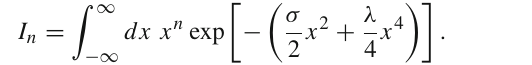
Fig. 5 The solutions to the thimble equation, Eq. (4.4), corresponding to φ 0 (Middle) and φ ± (Right), for the parameters { a = 1, b = 1, c = 1, d = 1, h = 0 } . In all the three figures, the green solid curves repre-